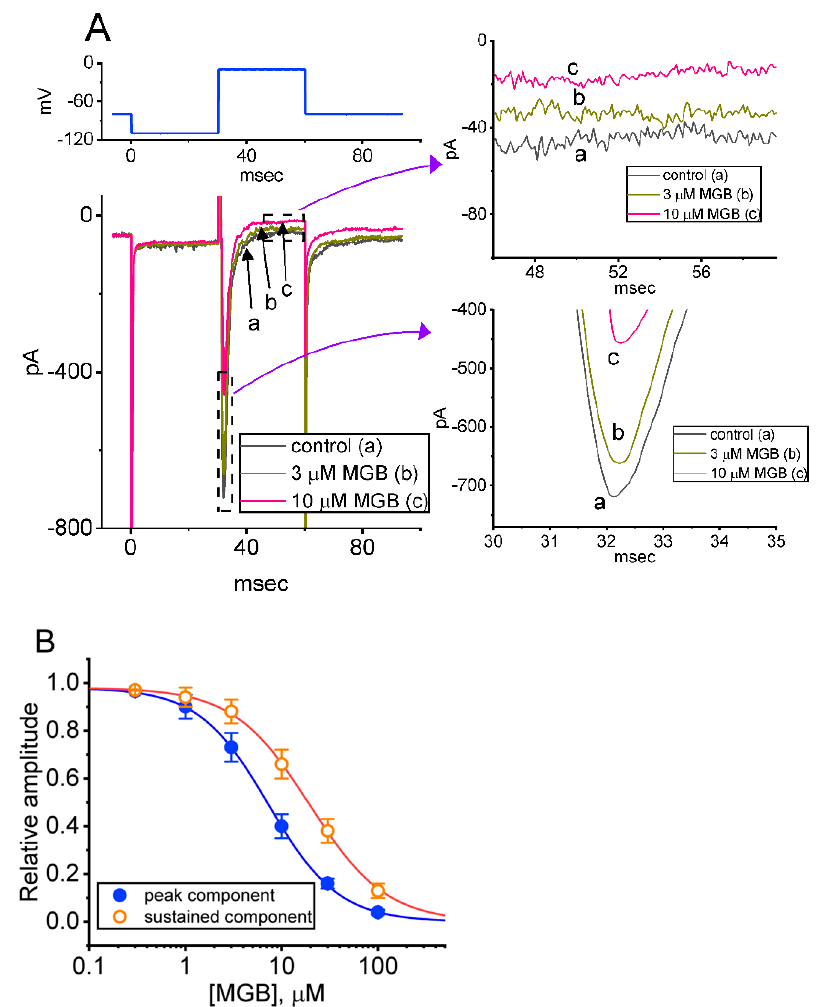
Figure 1. Effect of mirogabalin (MGB) on voltage-gated Na + current ( I Na ) identified in pituitary GH 3 cells. In this series of experiments, we bathed cells in Ca 2+ -free Tyrode’s solution, which contained 10 mM tetraethylammonium chloride (TEA) and 0.5 mM CdCl 2 , and the electrode that was used was filled up with a solution containing Cs + . ( A ) Representative current traces acquired in the control period (a) (i.e., absence of MGB) and during the exposure to 3 µ M MGB (b) or 10 µ M MGB (c). The voltage clamp protocol that we applied is illustrated in the upper part. The graphs shown in the right side of ( A ) indicate the expanded records from the left side (dashed boxes). ( B ) Concentration– response curve of MGB-induced block of peak (transient) I Na ( I Na(T) ) or sustained (late) I Na ( I Na(L) ) occurring in GH 3 cells. The continuous line drawn represents the goodness-of-fit to the modified Hill equation, as described in Section 4. The IC 50 values for the MGB-induced inhibition of I Na(T) and I Na(L) were optimally estimated to be 19.5 and 7.3 µ M, respectively. Each point represents the mean ± SEM (n =